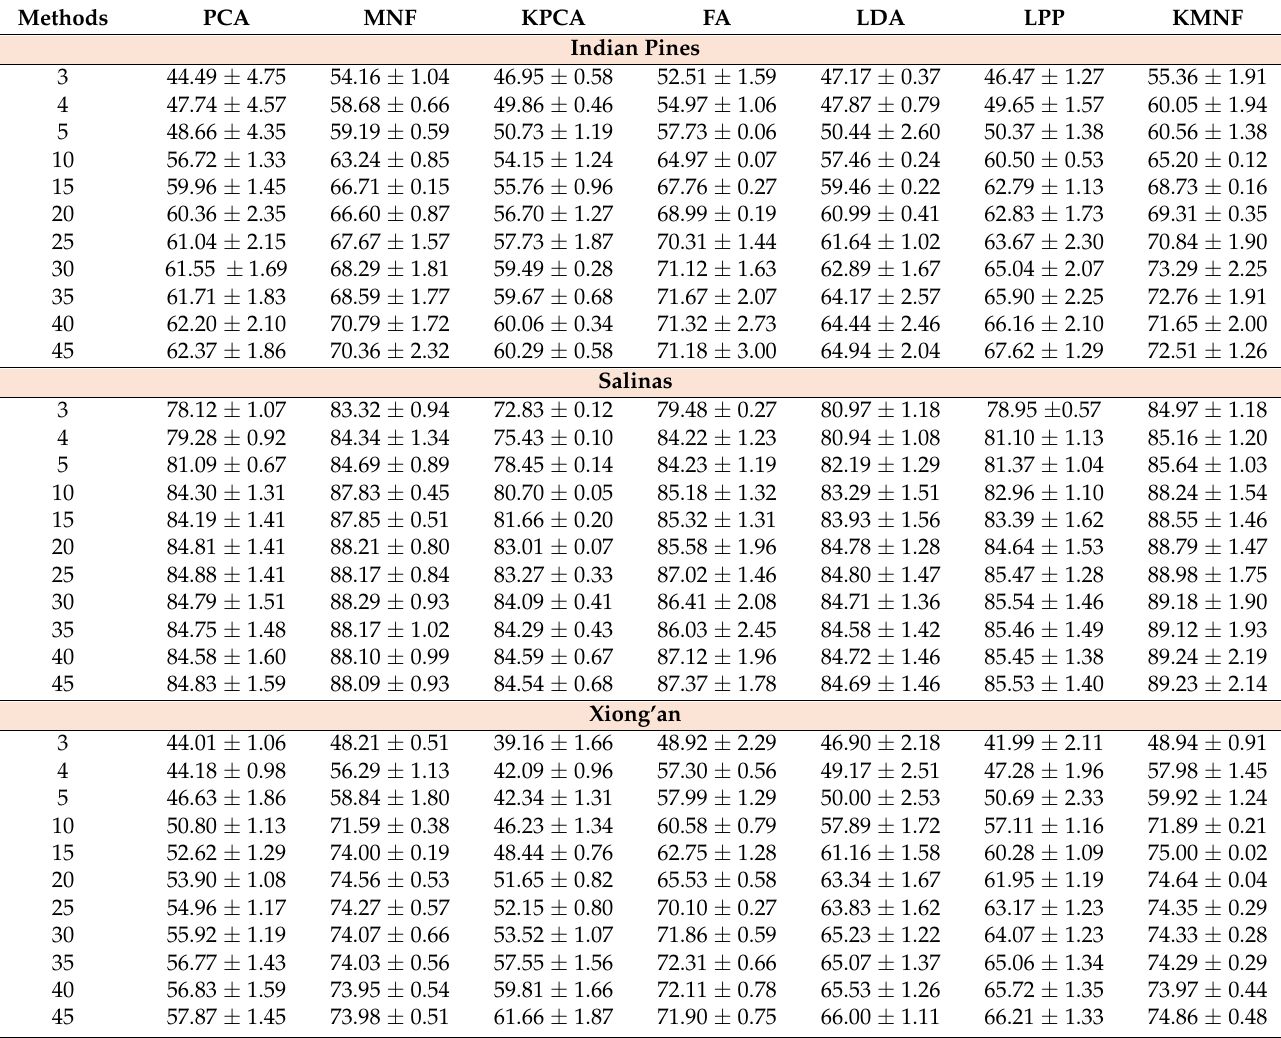
Table 5. The Kappa and confidence intervals of SVM classifier after each feature extraction